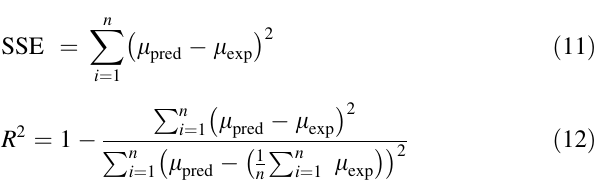
Fig. 4 Comparison between the polymer solution viscosities pre- dicted by ANFIS model and the experimentally determined viscosity; training data ( a ), test data ( b ). Response data have been transformed using base 10 log